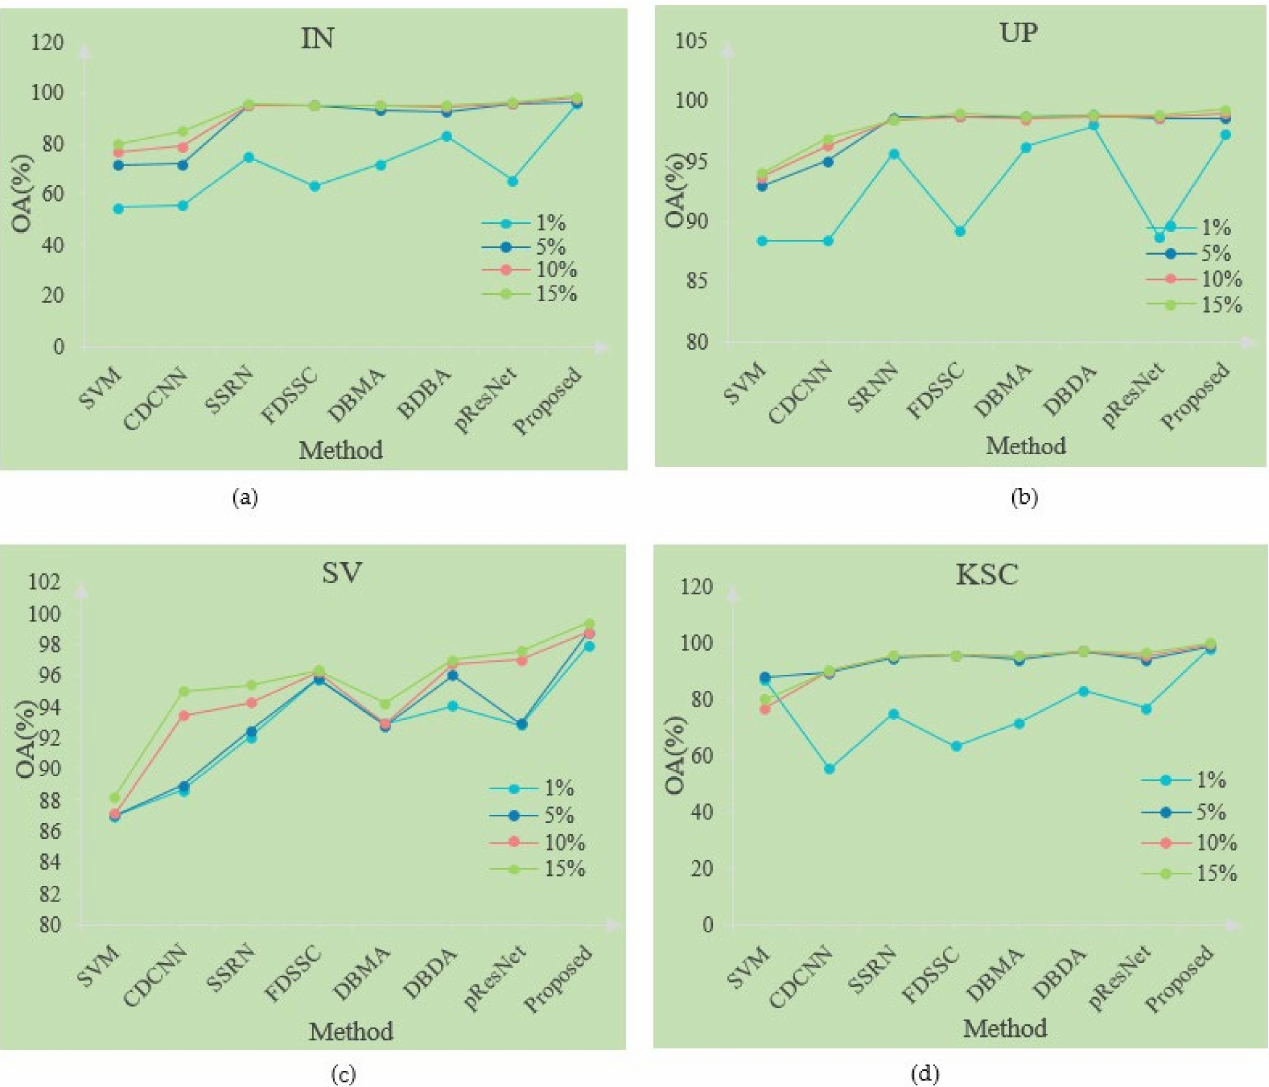
Figure 14. The classification performance of different methods is compared under different training sample ratios in IN, UP, SV and KSC data sets. ( a ) Classification performance of different methods on IN data set, ( b ) classification performance of different methods on UP data set, ( c ) classification performance of different methods on SV data set and ( d ) classification performance of different methods on KSC data